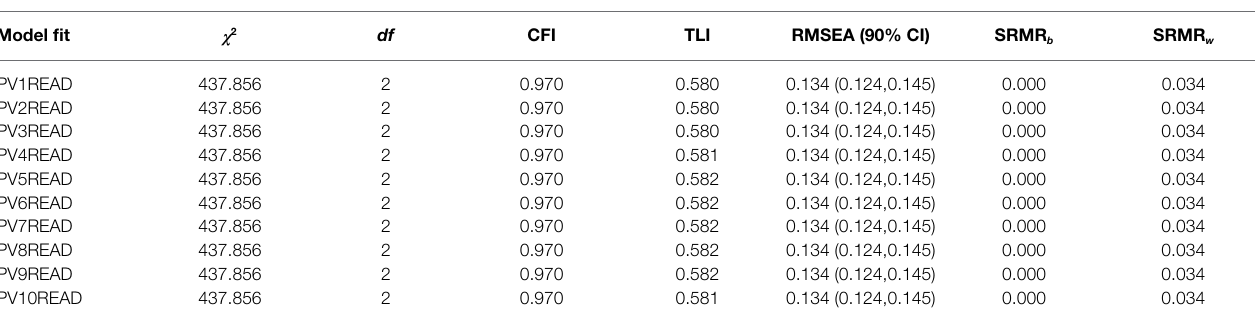
TABLE 4 | Fit indices for Model 2 . Model